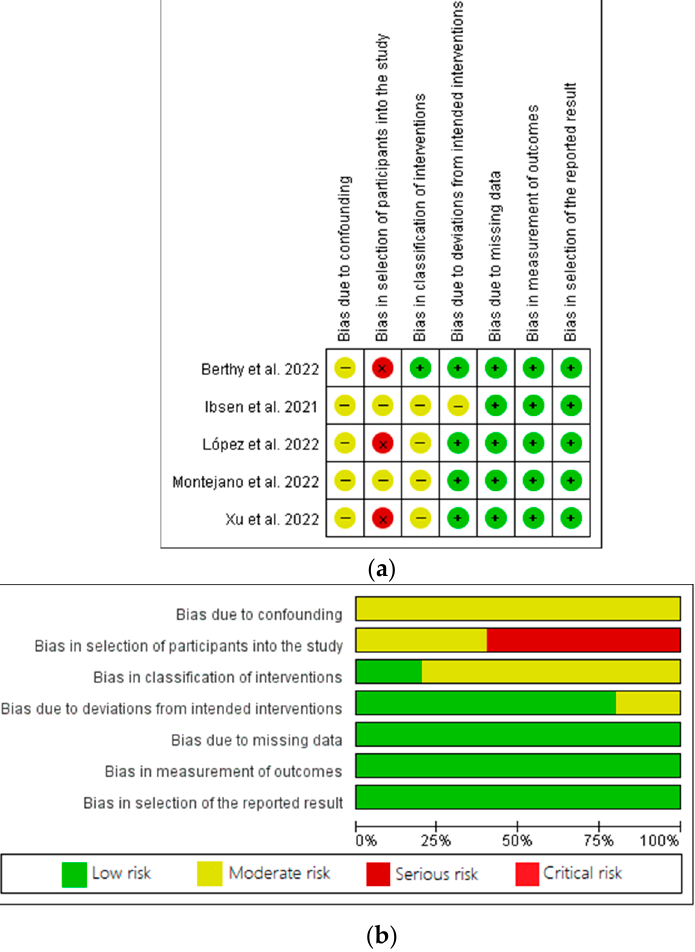
Figure 2. ( a , b ): Quality assessment of prospective cohort studies [22,25–28], according to the Cochrane collaboration standard scheme for bias and ROBINS-I tool.